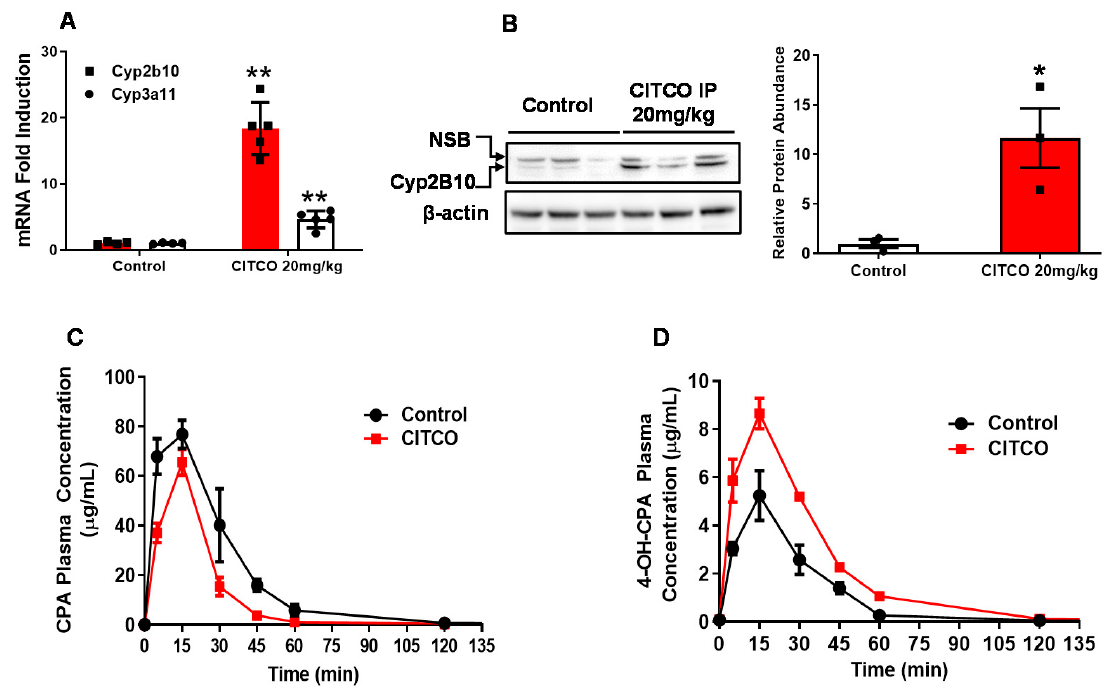
Figure 2. CITCO induces cyp2b10 expression and CPA bioactivation in hCAR-TG mice. hCAR-TG-mice were treated with vehicle control (corn oil) or CITCO (20 mg / kg body weight, IP), and livers were harvested for the detection of Cyp2b10 and Cyp3a11 mRNA ( A ) and CYP2B10 protein ( B ) expression. For PK studies, hCAR-TG-mice were pretreated with CITCO (20 mg / kg body weight, IP) for 24 h, followed by a single treatment with CHOP (80 mg / kg body weight, IP). Plasma concentrations of CPA ( C ) and 4-OH-CPA ( D ) over time were measured using LC-MS / MS methods. CPA and 4-OH-CPA values represent the mean ± SEM of 3 LC-MS / MS measurements. NSB: non-specific band. *, p < 0.05; **, p < 0.01. Table 1. Pharmacokinetic parameters of CPA and 4-OH-CPA after CITCO pretreatment in hCAR-TG- mice.